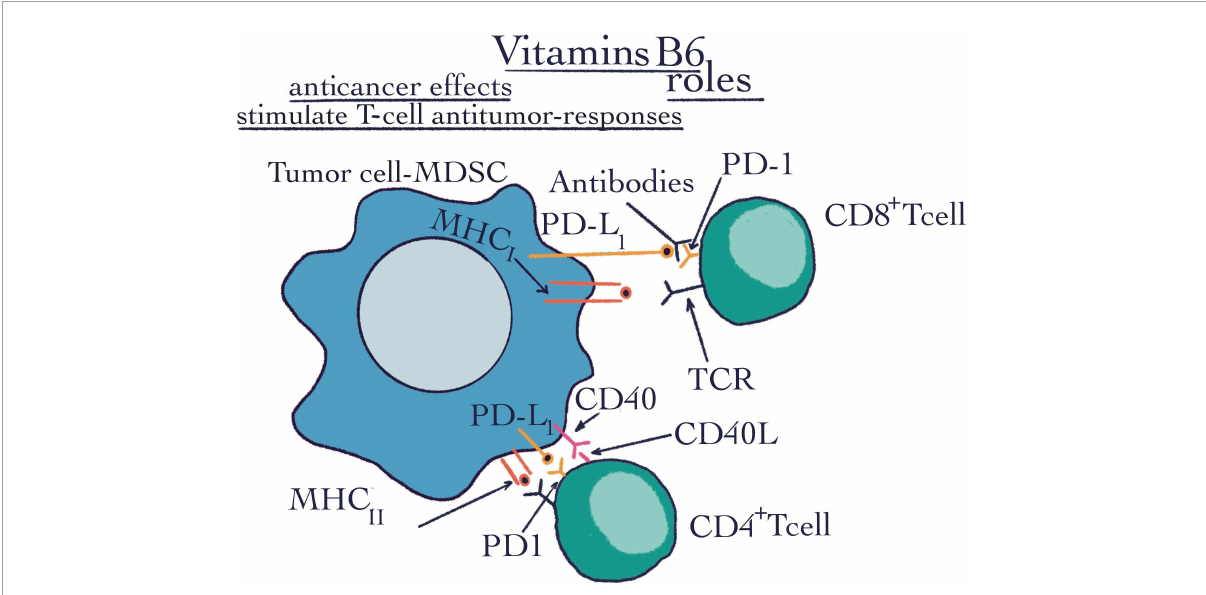
FIGURE4 Vitamins B6 roles. The flow cytometry technique highlighted the roles of vitamins B6 such as anti-cancer effects and stimulating T-cell anti-tumor responses. CD4 + T-cell, CD4 + positive T-cell is a subtype of lymphocyte, they are MHCII restricted and are important mediators of adaptive immunity; CD8 + T-cell, CD8 + positive T-cell is a critical subpopulation of MHCI restricted T-cell; MHCI, major histocompatibility complex class I; MHCII, major histocompatibility complex class II; PD-1, programmed cell death protein 1; PDL-1, programmed cell death ligand 1; CD40, a cluster of differentiation 40; CD40-L, a cluster of differentiation 40 ligand; R, receptor; TCR, tumor cell receptor; MDSC, myeloid-derived suppressor